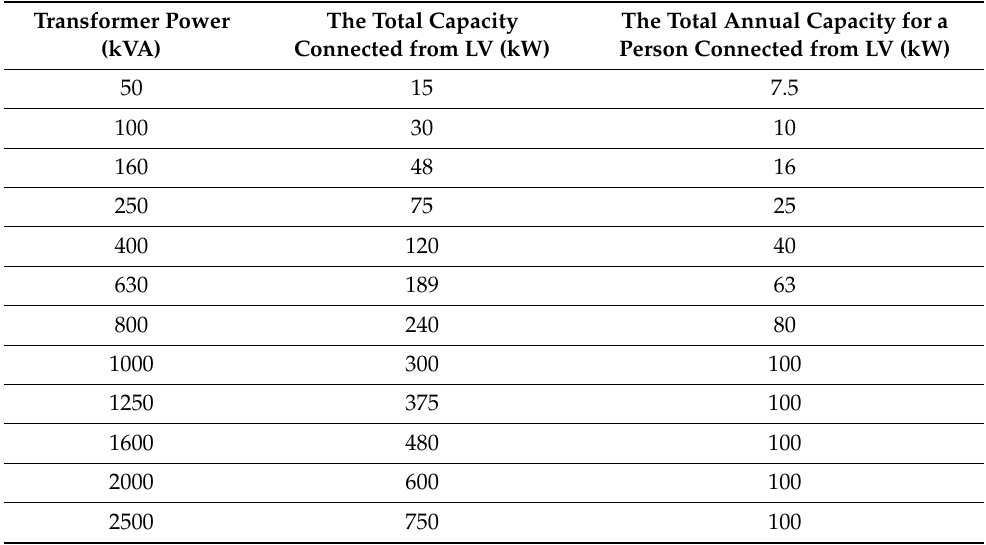
Table 5. The allowed capacity of power plants is connected from the LV level to the distribu- tion